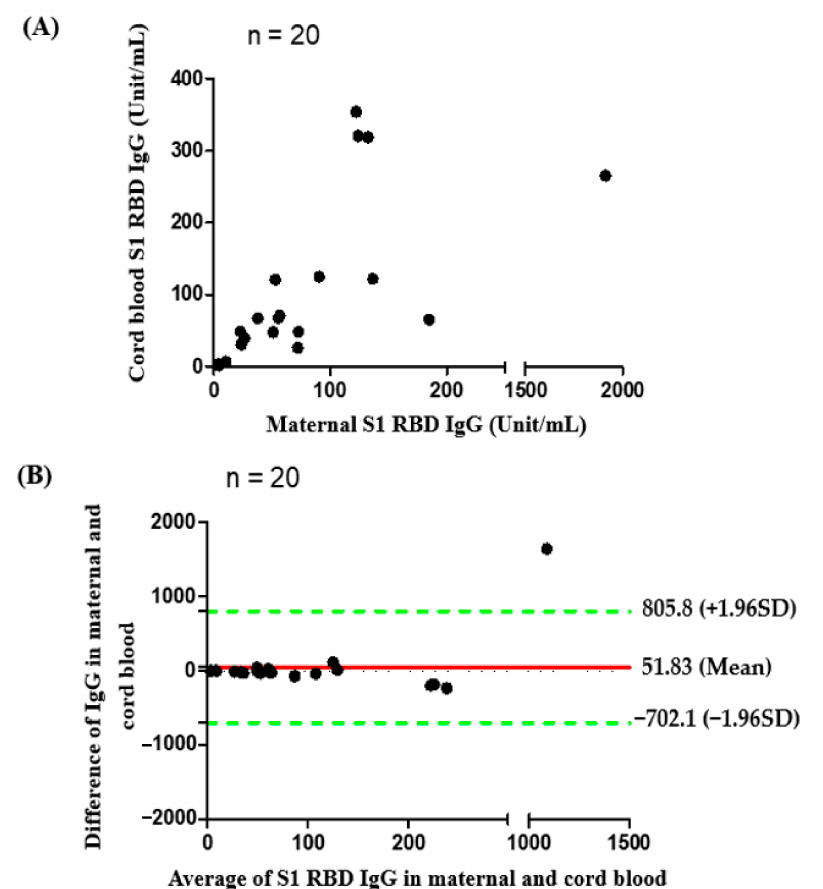
Figure 2. ( A ) Correlation of S1 receptor binding domain IgG antibodies between maternal and cord blood ( n = 20, with two dose n = 16, one dose n = 4 Rho = 0.7669, p value < 0.0001); ( B ) Bland and Altman plot. The difference of S1 receptor binding domain IgG antibodies in maternal and cord blood in relation to the average of the two ( n = 20, with two dose n = 16, one dose n = 4). Green lines indicate the limits of agreement ( ± 1.96 standard deviation).